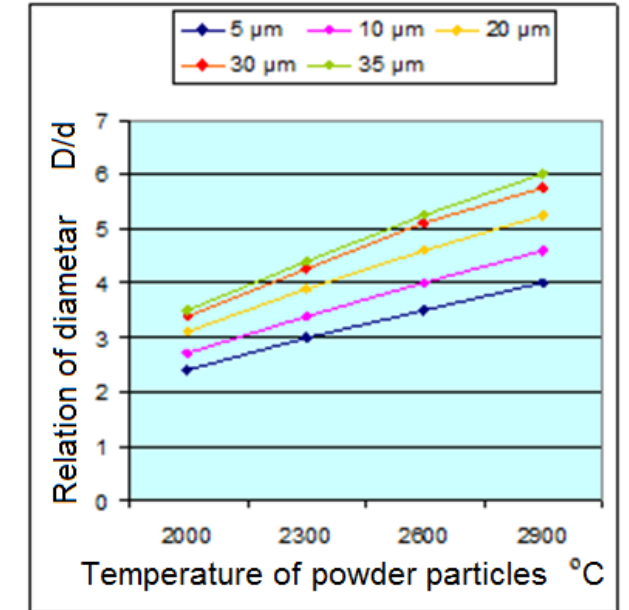
Figure 2 – The D/d ratio depending on the temperature in Al 2 O 3 particles Рис . 2 – Соотношение D/d в зависимости от температуры частиц Al 2 O 3 Слика 2 – Однос D/d у зависности од температуре честица Al 2 O